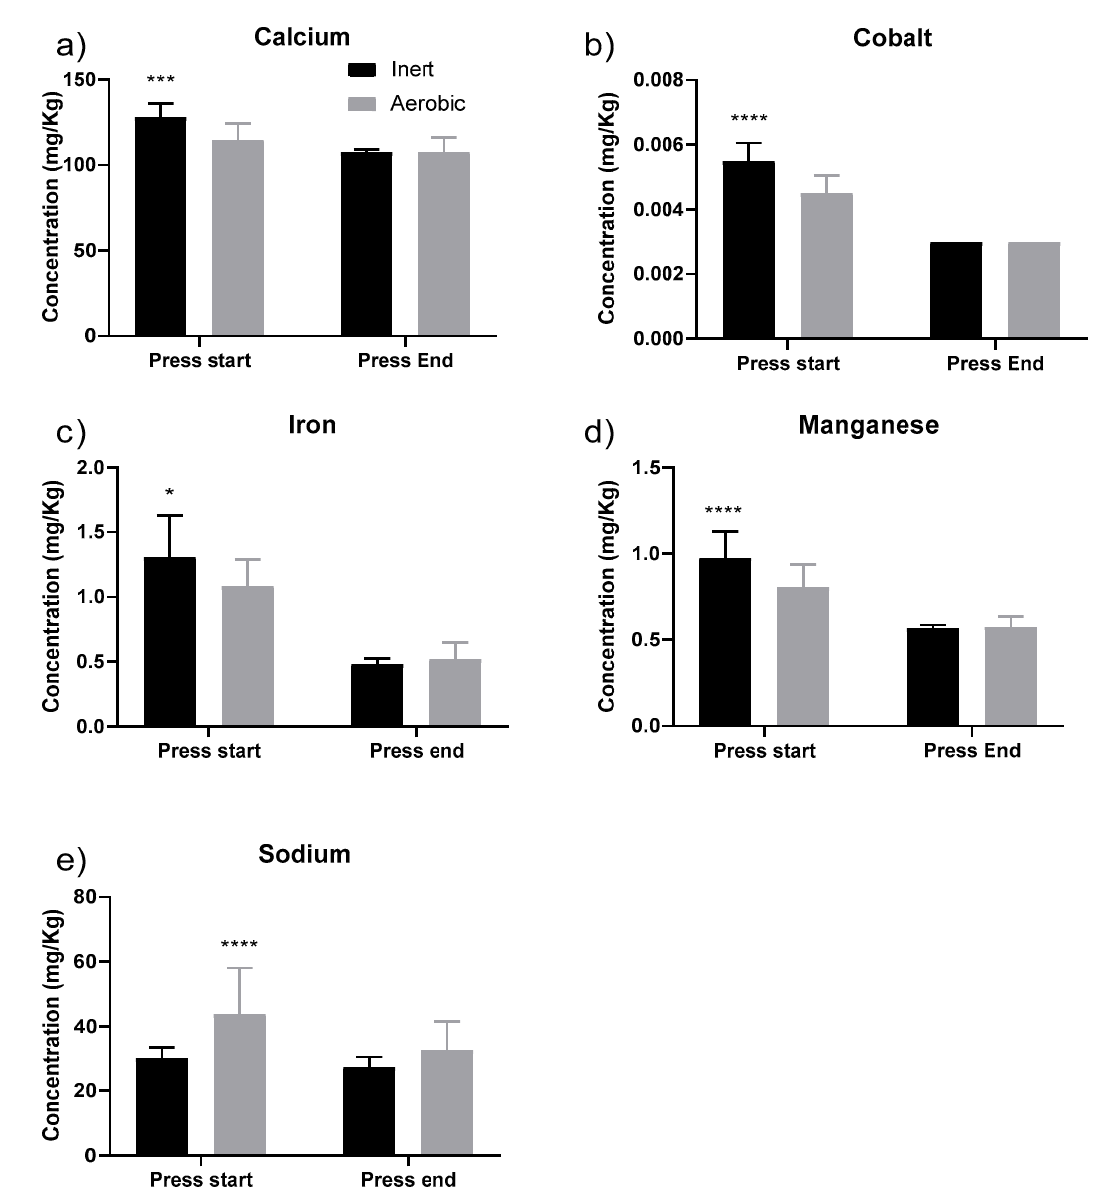
Figure 2. Ca ( a ), Co ( b ), Fe ( c ), Mg ( d ), and Na ( e ) metal ions measured in Chardonnay juice that were significantly impacted by oxygen exposure during pressing, with juices obtained using an inert pressing technique (“Inert”, black) compared to juices obtained using an aerobic pressing technique (“Aerobic”, grey). Significant interactions are indicated as follows: not significant (ns) for p value > 0.05; * p value ≤ 0.05; ** p value ≤ 0.01; *** p value ≤ 0.001; **** p value ≤ 0.0001.